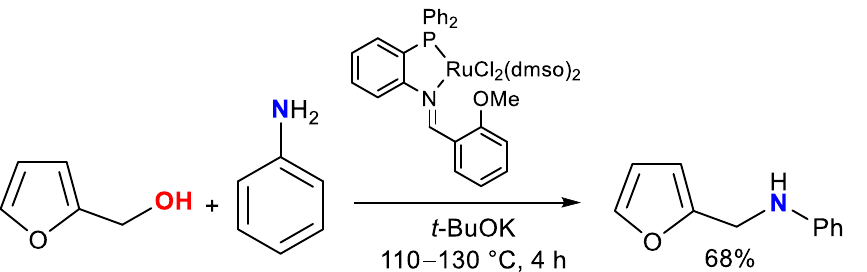
complex Ti III0.2 Ti IV0.8 (NTf 2 ) 2 (O) x (OH) y (H 2 O) z ·2.5H 2 O (Table 2 Entry 7) [31]. Indeed, only 2